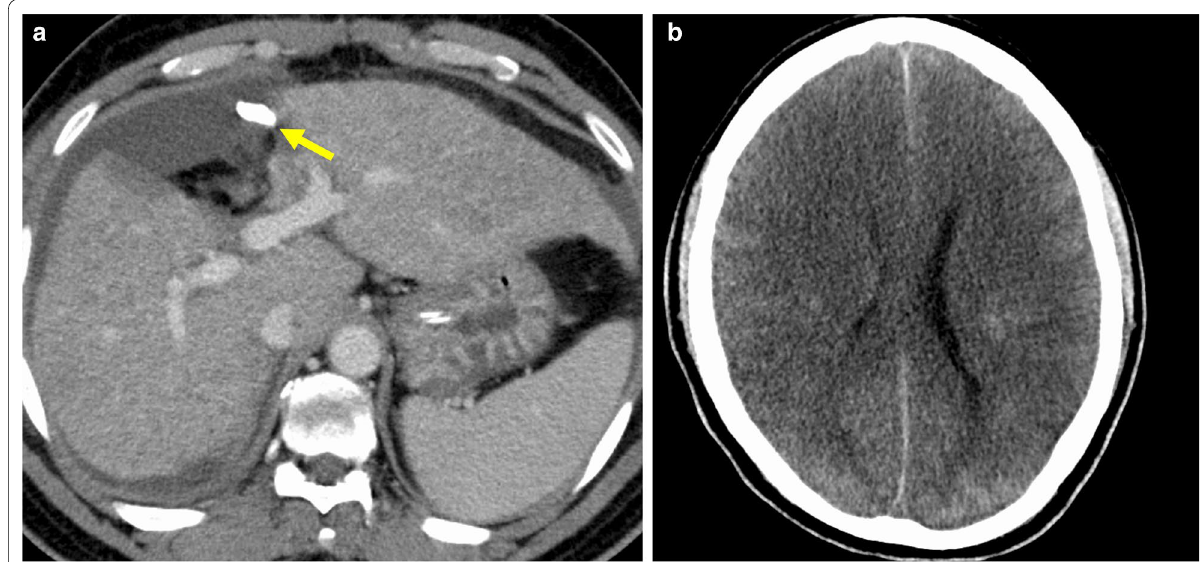
Fig. 4 Contrast-enhanced computed tomography image performed on postoperative days 13 ( a ) and 16 ( b ). Liver parenchyma showed a slight inhomogeneous enhancement without apparent occlusion of the hepatic arteries and portal vein. The arrow indicates an abdominal drain ( a ). Diffuse cerebral edema and impaired enhancement of cerebral parenchyma were noted ( b